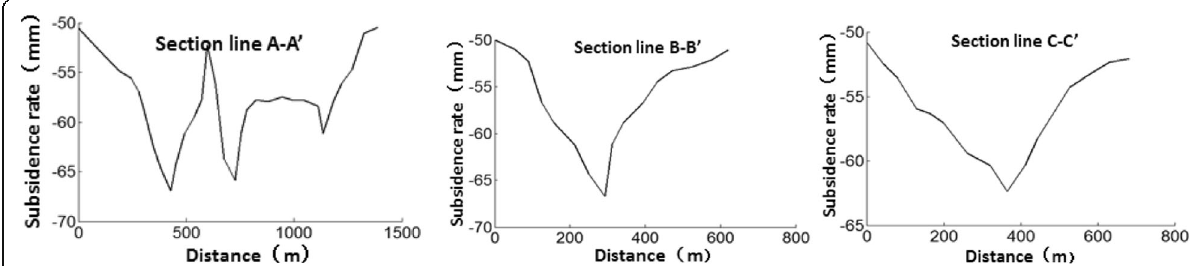
Fig. 10 Figure of the deformation gradient on two sides of the section of subsidence funnel